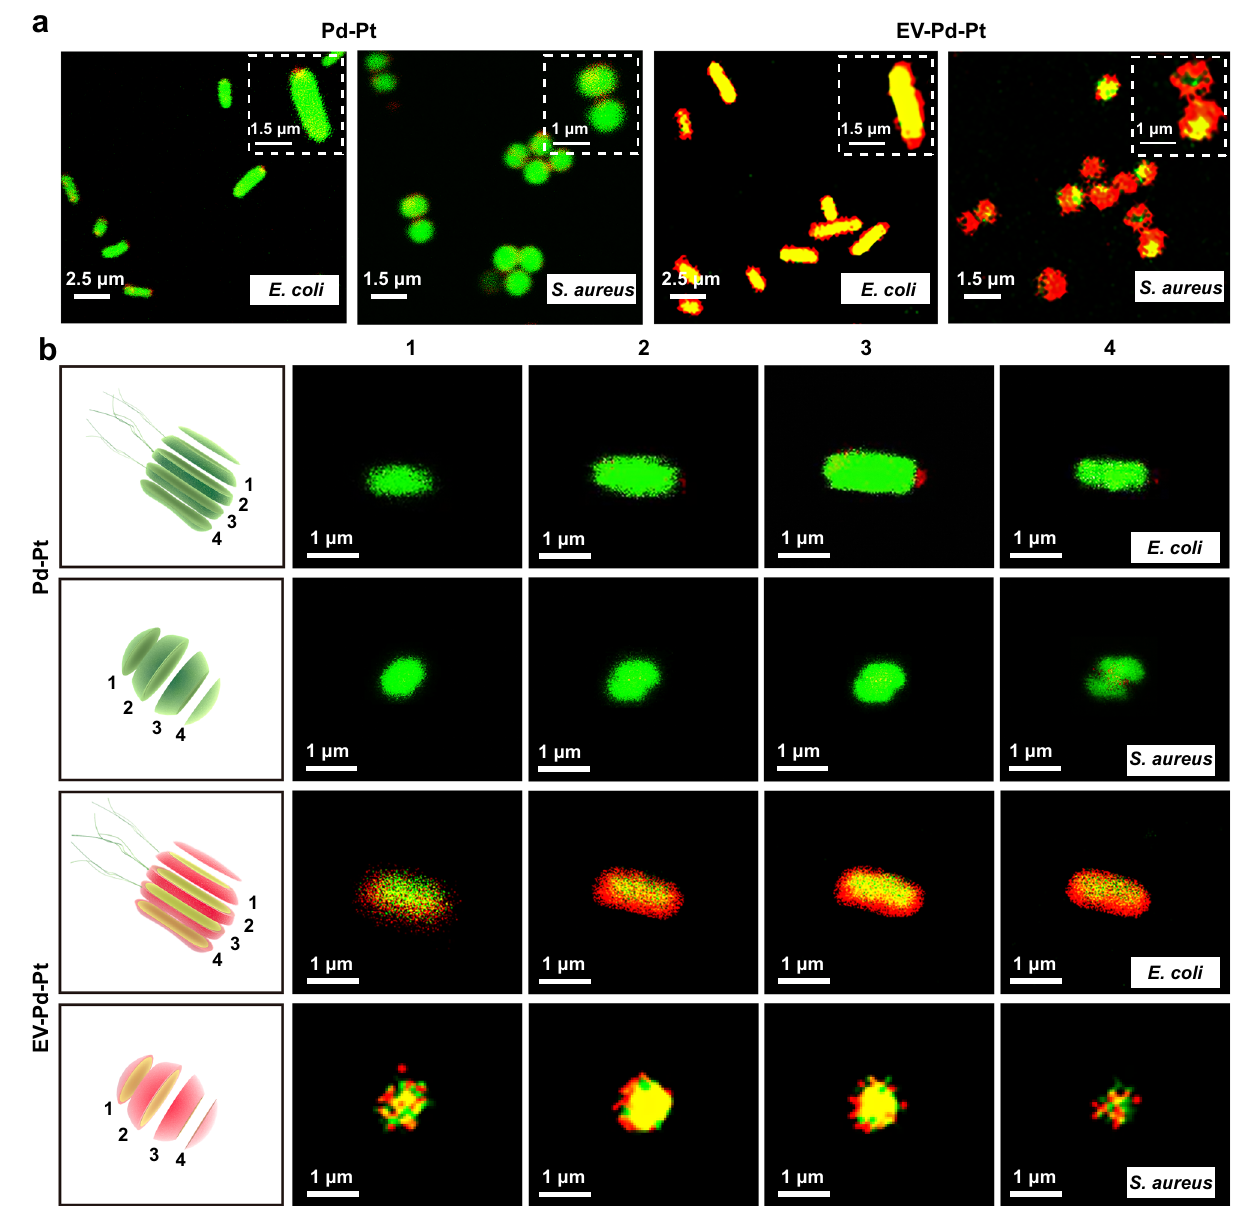
Fig. 4 | Interaction of EV-Pd-Pt and Pd-Pt nanoparticles with S. aureus and E. coli , respectively. a CLSM images of E. coli and S. aureus treated with Pd-Pt and EV-Pd-Pt (Pd-Pt concentration of 50 μ g/mL) for 30min, respectively. b CLSM tomography images of E. coli and S. aureus after 30min incubation with Pd-Pt and